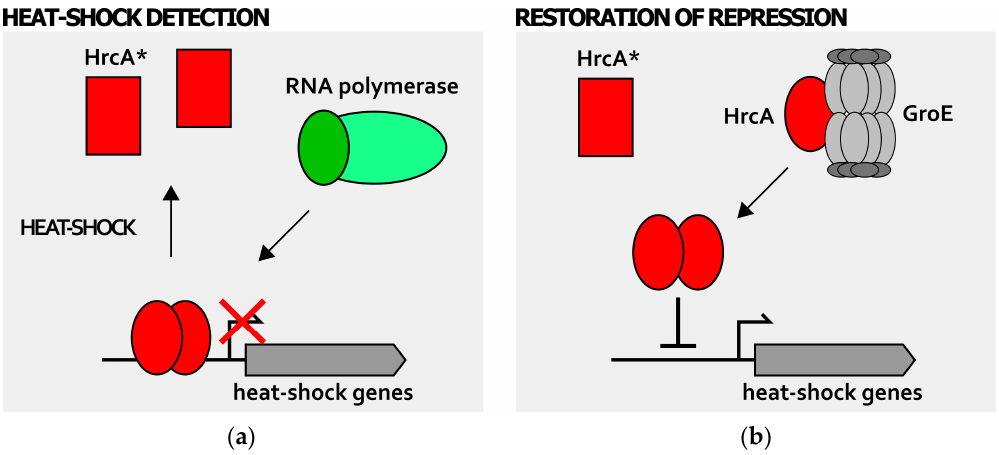
Figure 5. Direct temperature detection by HrcA. At 37 °C, HrcA binds its operators that overlap the core promoter of P gro and P hrc and, in combination with HspR, they repress gene transcription. Upon temperature upshift ( a ), HrcA (red oval) goes through a major structural change and acquires an inactive conformation (represented by a red rectangle and here named HrcA*), detaching from its operator (this event is depicted by a solid arrow) and relieving transcriptional repression; when the temperature returns to the physiological level ( b ), HrcA directly interacts with the GroE chaperonin and regains its native conformation (red oval), retrieving its DNA-binding capabilities (solid arrow) and restoring transcriptional repression (solid hammerhead). The RNA polymerase containing the vegetative σ factor is represented by green ovals (dark green oval depicts vegetative σ factor, while light green oval represents the core RNA polymerase). Bent arrow indicates the transcription start site.